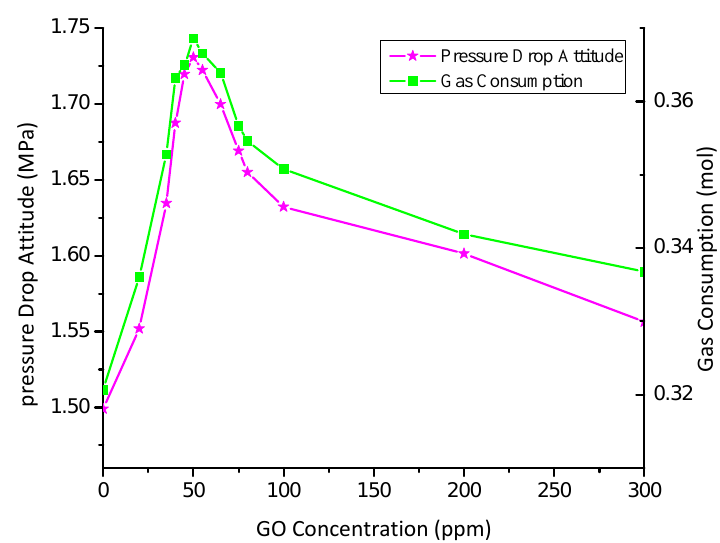
Figure 8. The effect of GO concentrations on pressure drop attitude and gas consumption .